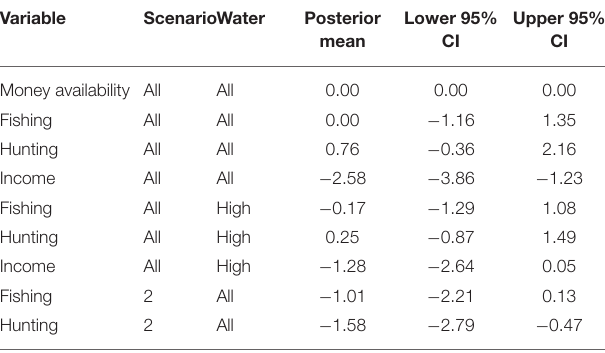
TABLE 2 | MCMC results for the multinomial regression: we report the posterior mean and the 95% credible interval for energy budget allocation model.